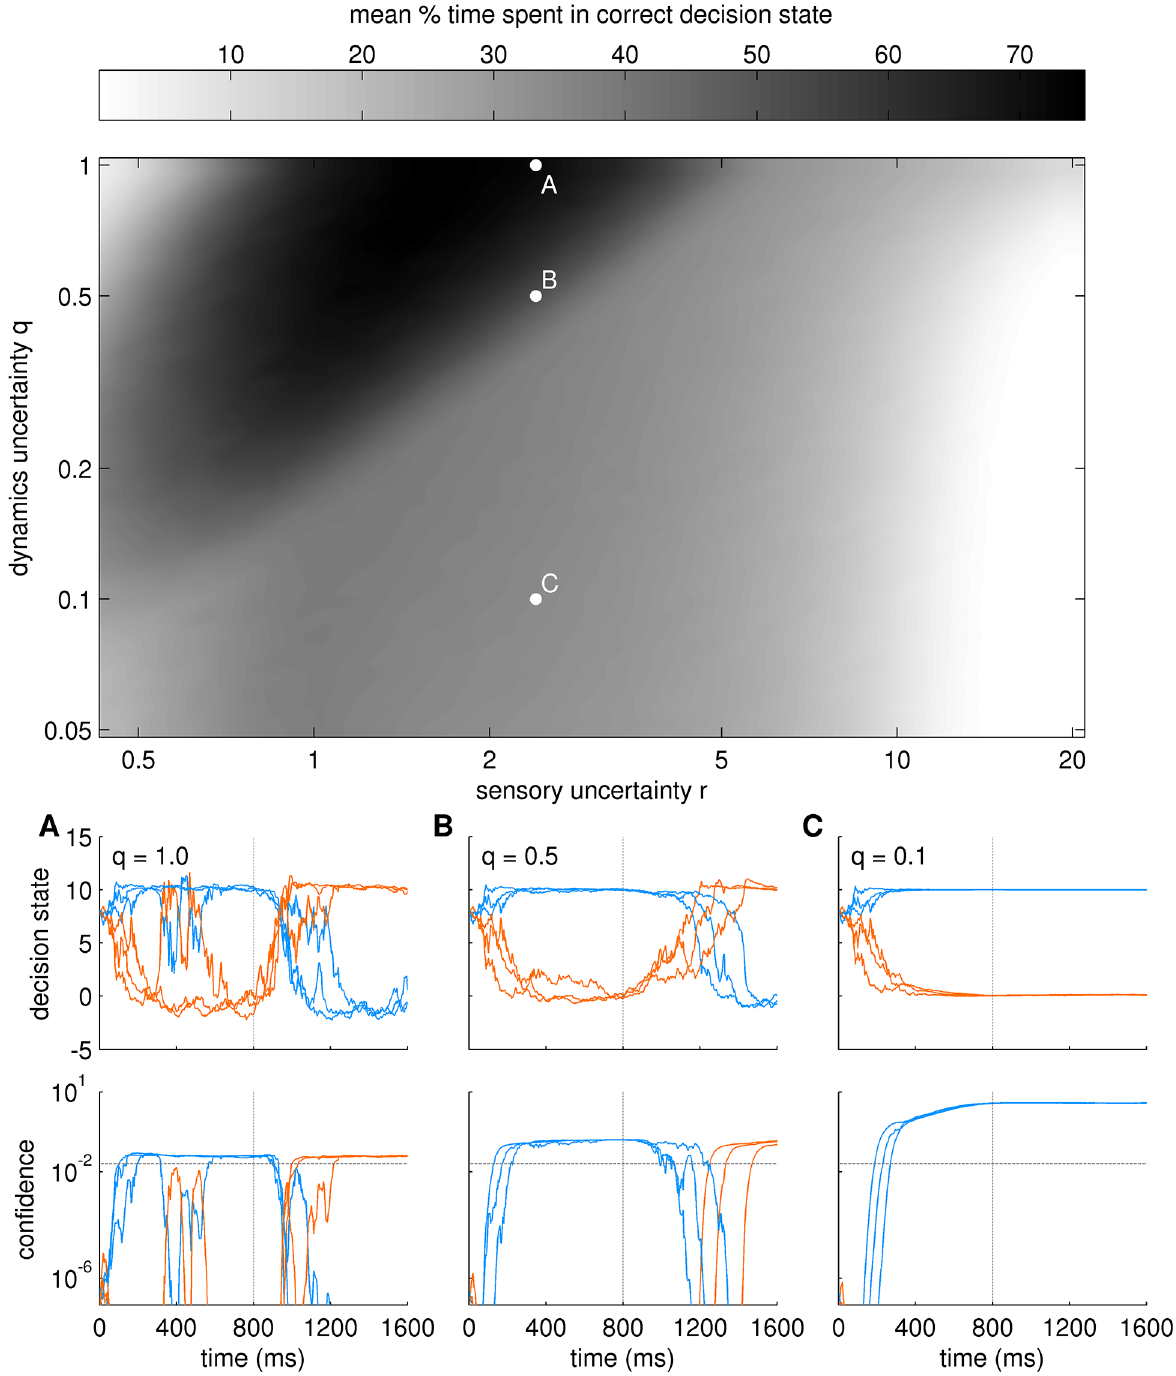
Fig 7. Re-decision behaviour of Bayesian attractor model for switching stimuli. Noisy exemplars of alternative 1 (blue) and subsequently of alternative 2 (orange) were shown with a switch at 800ms (cf. Fig 2). For varying combinations of sensory uncertainty r and dynamics uncertainty q we plotted the mean (over 1000 trials) percentage of time spent in the correct decision state (grey shading). (A-C) Bottom panels show three example trials for the parameter combinations indicated by the corresponding points in the main panel. Top row: decision state, bottom row: confidence (log-scale) with threshold (grey, dashed line). A: fast, but sometimes fickle re-decisions, B: slower but reliable re-decisions, C: no re-decisions. For point A the mean % time spent in the correct decision is larger, because decision and re-decisions are on average faster. The overall level of confidence reached increases from A to C, as previously shown in Fig